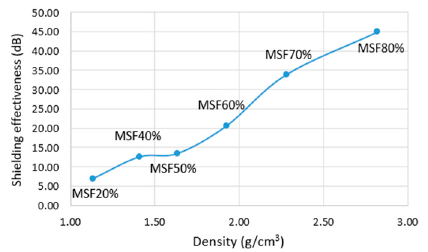
Figure 19. SE dependence of density. Iron scale flakes. Frequency—10 GHz.